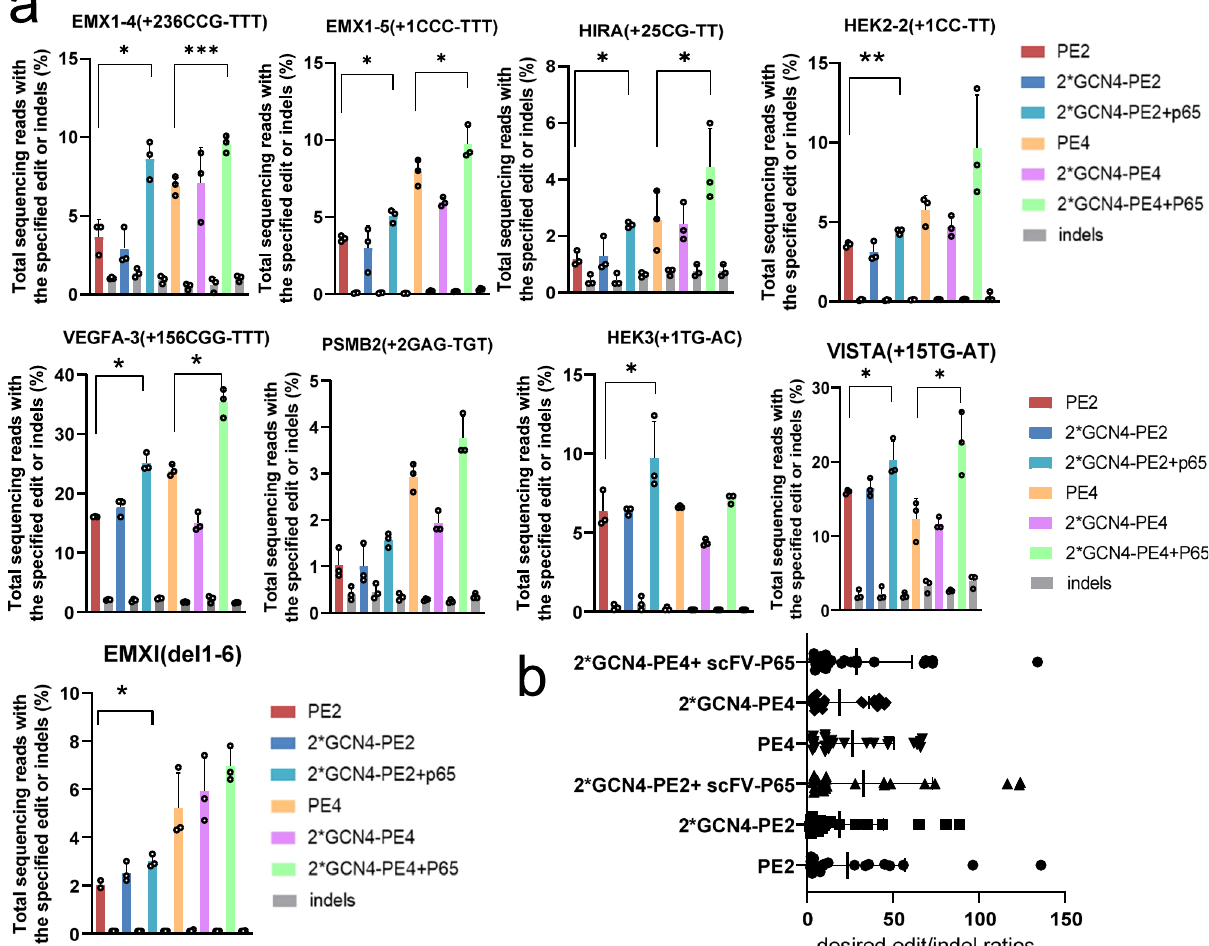
Fig. 2 | P65 improved PE2 prime editing ef fi ciency at various genomic loci. a PCR amplicons from the target regions were analyzed by targeted deep sequencing. The reads harboring only correct edits were counted to evaluate the editingef fi ciency,andthereadsharboringanyundesiredinsertionordeletionwere countedtoevaluatetheindelfrequency.Thegraybarindicatestheindelfrequency coupled with the editing ef fi ciency indicated by the left closest bar. Statistical